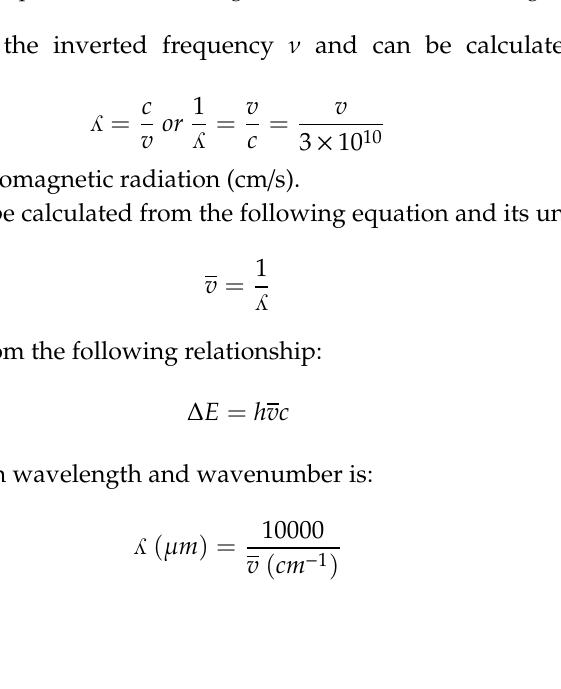
Figure 2. Spectrum of electromagnetic waves and infrared